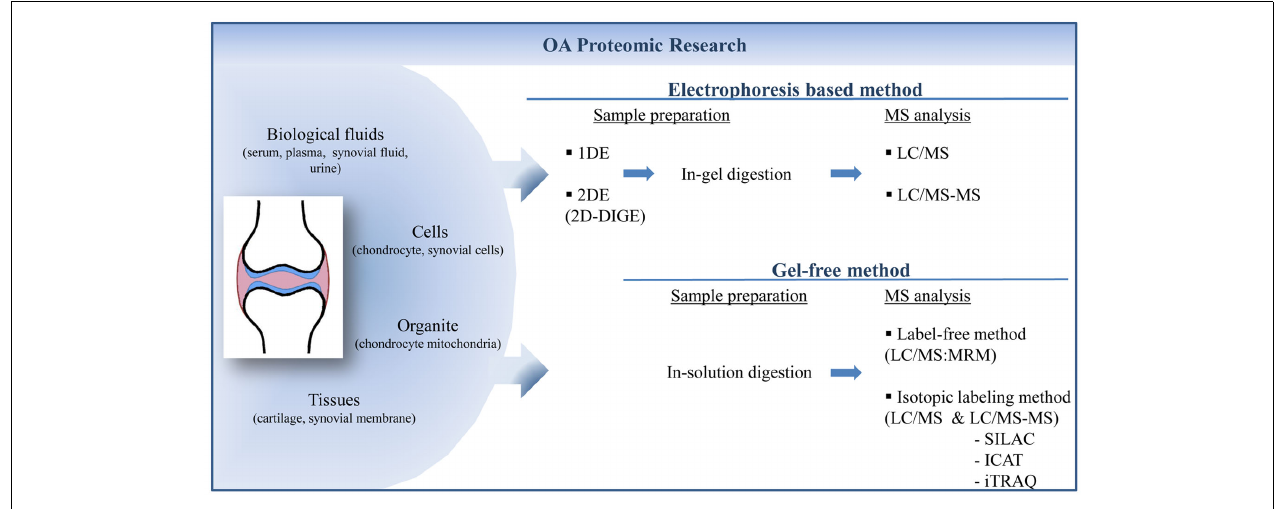
which could be quantified directly by mass spectrometry analysis. 1DE, one-dimensional electrophoresis; 2DE, two-dimensional electrophoresis; 2D-DIGE, two-dimensional-differential in-gel electrophoresis; LC, liquid chromatography; MS, mass spectrometry; MRM, multiple-reaction monitoring; SILAC, stable isotope labeling by amino acid; ICAT, Isotope-coded affinity tag; iTRAQ, isobaric tag for relative and absolute